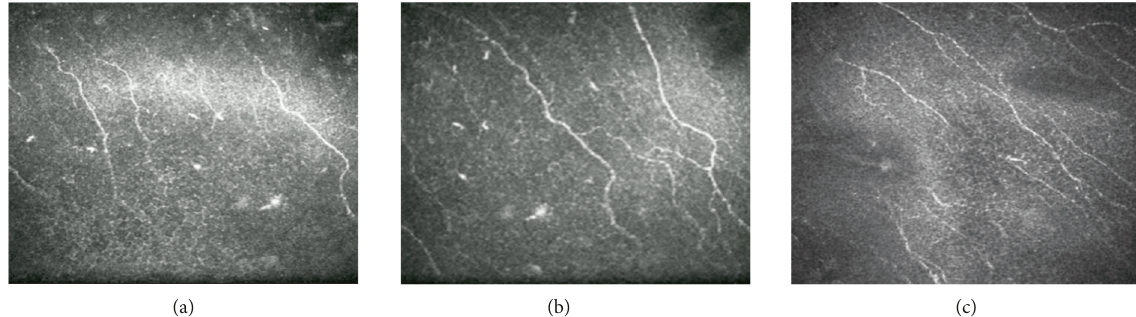
Figure 5: Illustrative example of IVCM showing the subbasal nerve fi ber and dendritiform cells in the study group at baseline (a), 1 month (b), and 3 months follow-up